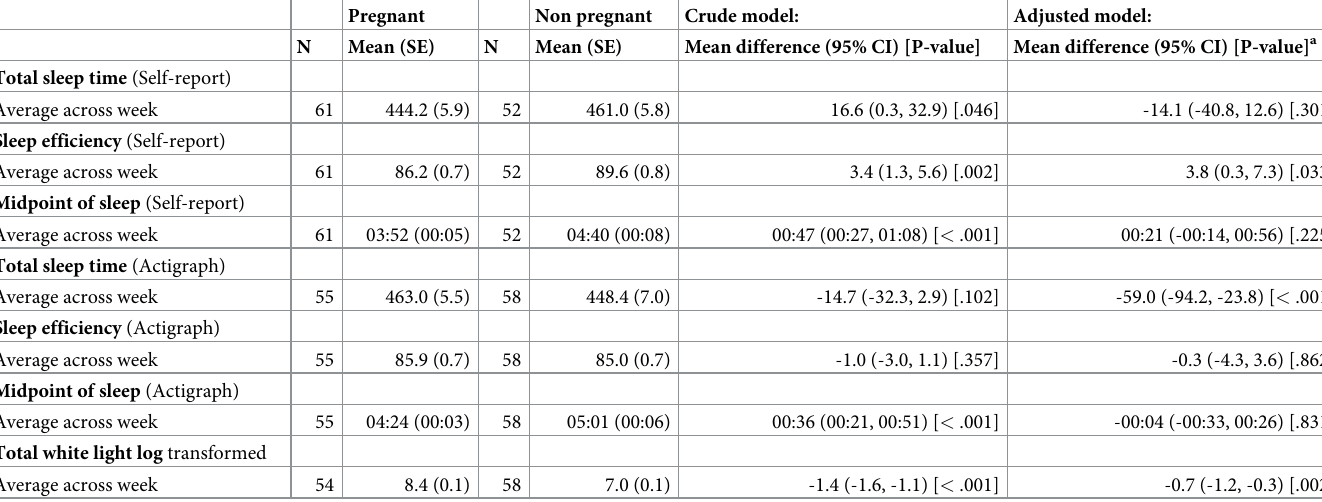
Table 2. Sleep and light exposure variables for each weekday, and the association between pregnant and non-pregnant women.